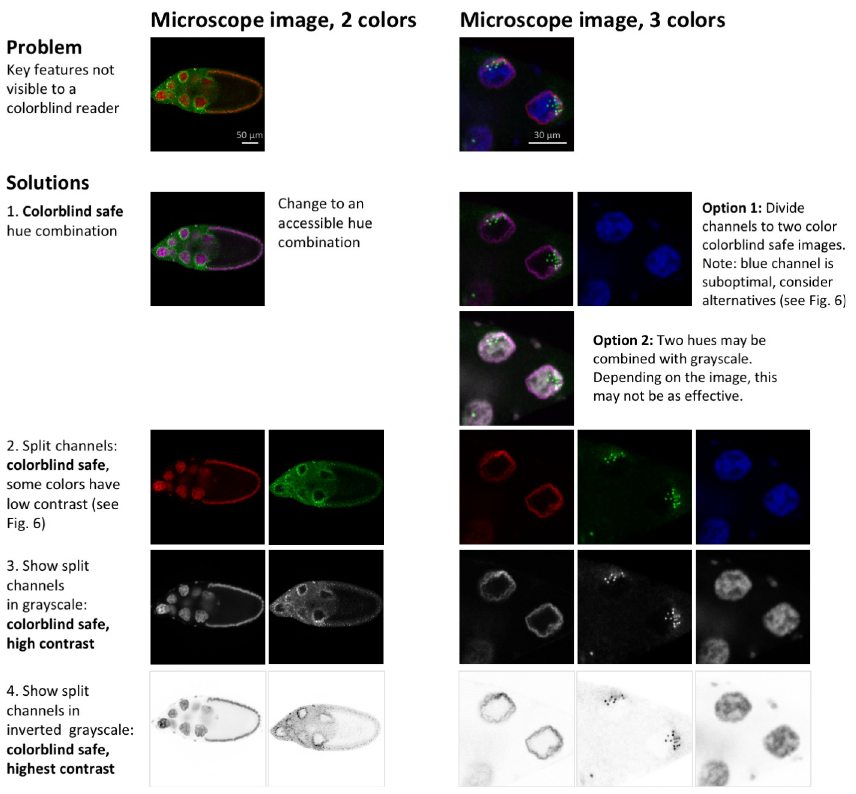
Fig 8. Strategies for making 2- or 3-channel microscope images colorblind safe. Images in the first row are not colorblind safe. Readers with the most common form of colorblindness would not be able to identify key features. Possible accessible solutions are shown: changing colors/LUTs to colorblind-friendly combinations, showing each channel in a separate image, showing colors in grayscale and inverting grayscale images to maximize contrast. Solutions 3 and 4 (show each channel in grayscale, or in inverted grayscale) are more informative than solutions 1 and 2. Regions of overlap are sometimes difficult to see in merged images without split channels. When splitting channels, scientists often use colors that have low contrast, as explained in Fig 6 (e.g., red or blue on black). Microscope images show D . melanogaster egg chambers (2 colors) and nurse cell nuclei (3 colors) [18]. All images of egg chambers and nurse cells respectively have the same scale. LUT, lookup